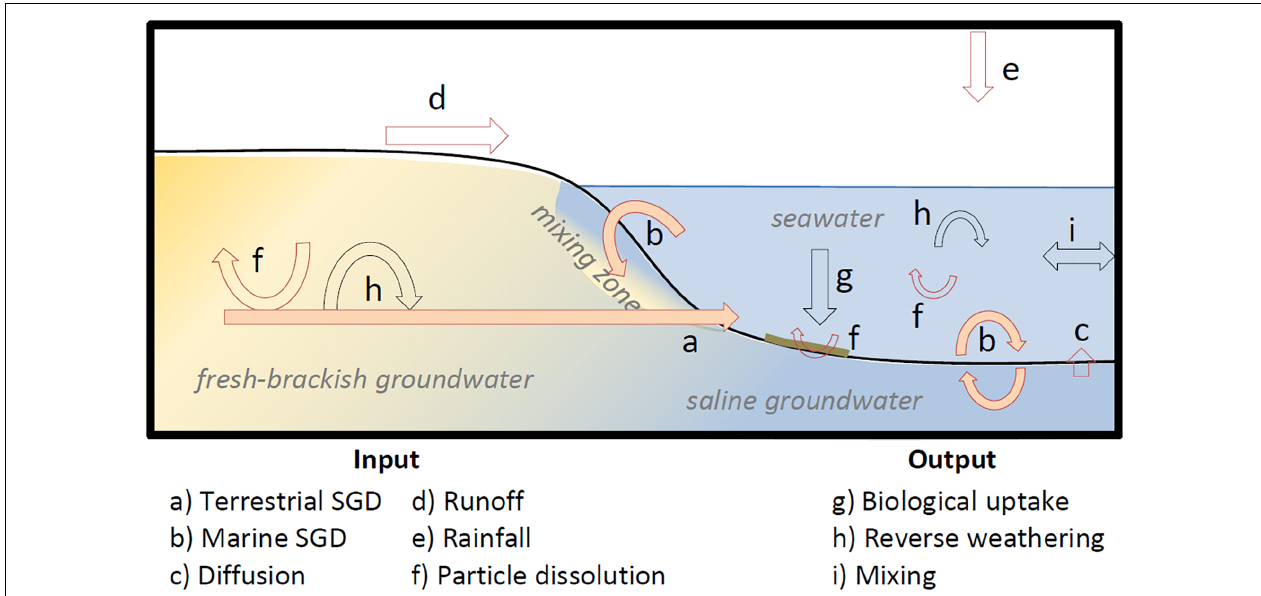
FIGURE 1 | Conceptual figure illustrating different processes governing DSi concentrations in coastal waters and coastal sediments/aquifer. Red arrows represent sources of DSi and black arrows represent sinks of DSi. Orange filled arrows represent hypothetical SGD flow paths, including terrestrial groundwater (a) and marine groundwater (b). Yellow colors represent fresh-brackish waters and blue colors represent saline water. The mixing zone between fresh and saline groundwater is called subterranean estuary (STE). The green line at the seafloor represents biogenic silica which has deposited e.g., after a phytoplankton bloom (Kowalski et al., 2013). The respective processes which lead to an input or output of DSi are labeled in the lower panel. Sources and sinks can vary with respect to the environmental boundary conditions, the size of the arrows is thus not representative for the quantity of their respective